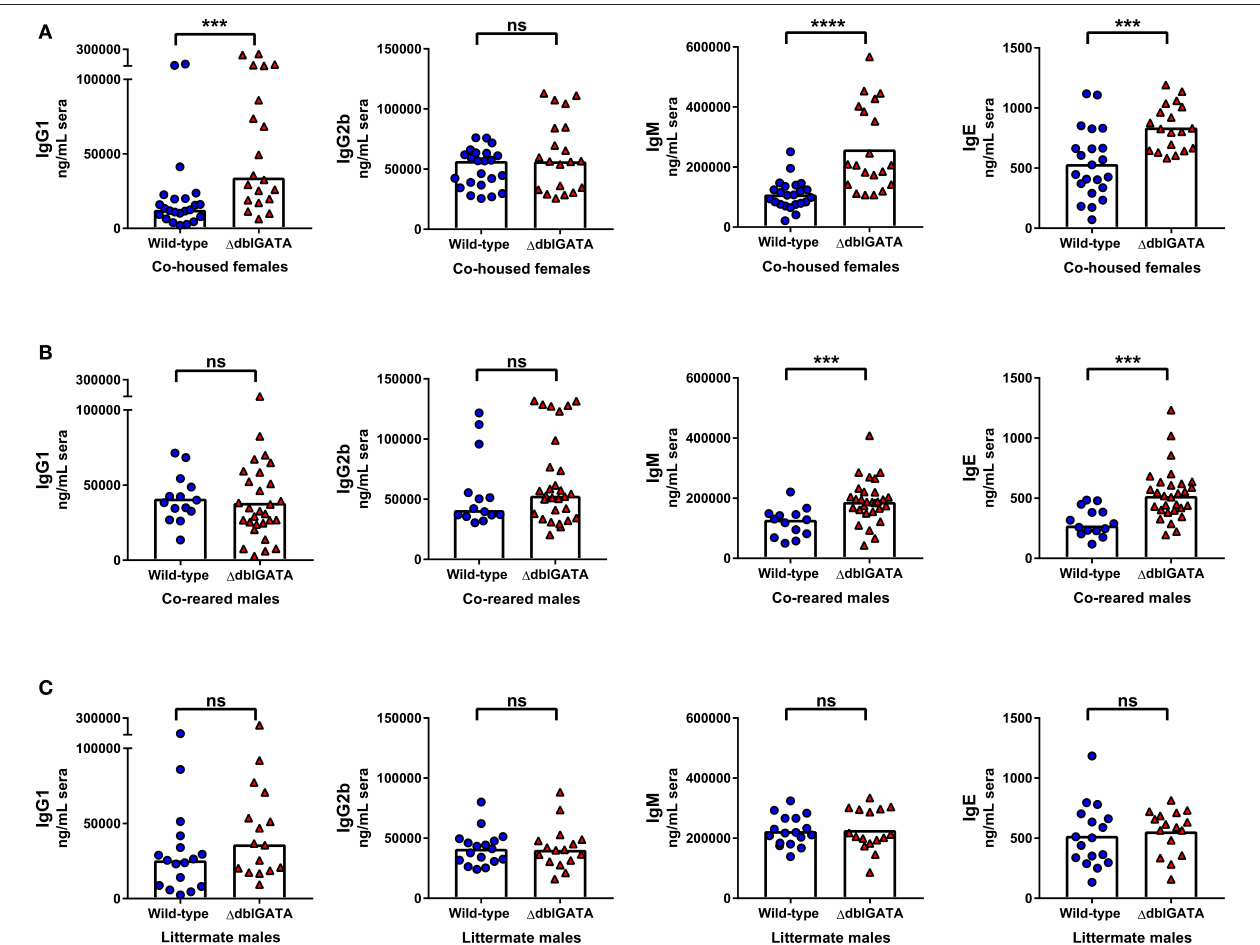
FIGURE 4 | Rearing conditions rather than an absence of eosinophils impact steady-state circulating antibody levels. 6–11 week old female wild-type and 1 dblGATA BALB/cJ mice were co-housed for 1 week (“co-housed”) prior to collecting sera. Male wild-type and 1 dblGATA BALB/cJ mice were raised in the same cage from birth but born to dams of different genotypes (“co-reared”) or raised in the same cage from birth and born to heterozygous 1 dblGATA dams (“littermates”), and sera were collected when mice were over 6 weeks old. Serum antibody levels were measured by ELISA. (A) Serum IgG1, IgG2b, IgM and IgE levels in co-housed female mice. Data shown are pooled from four independent experiments, with a combined n = 19–23 in each group. IgG1, IgG2b, and IgM data column heights are at the median value for each group and data were analyzed by a Mann-Whitney test; the IgE data column height is at the mean value and data were analyzed by an unpaired t -test. (B) Serum IgG1, IgG2b, IgM, and IgE levels in co-reared male mice. Data shown are pooled from four independent experiments, with a combined n = 14–29 in each group. The IgG1 data column height is at the mean value for each group and data were analyzed by an unpaired t -test; IgG2b, IgM, and IgE data column heights are at the median value for each group and data were analyzed by a Mann-Whitney test. (C) Serum IgG1, IgG2b, IgM, and IgE levels in male littermate mice. Data shown are pooled from three independent experiments, with a combined n = 16–17 in each group. IgG1 and IgG2b data column heights are at the median value for each group and data were analyzed by a Mann-Whitney test; IgM and IgE data column heights are at the mean value for each group and data were analyzed by an unpaired t -test. Each data point is representative of an individual mouse. ns, no statistical differences; *** = p ≤ 0.001; **** = p ≤